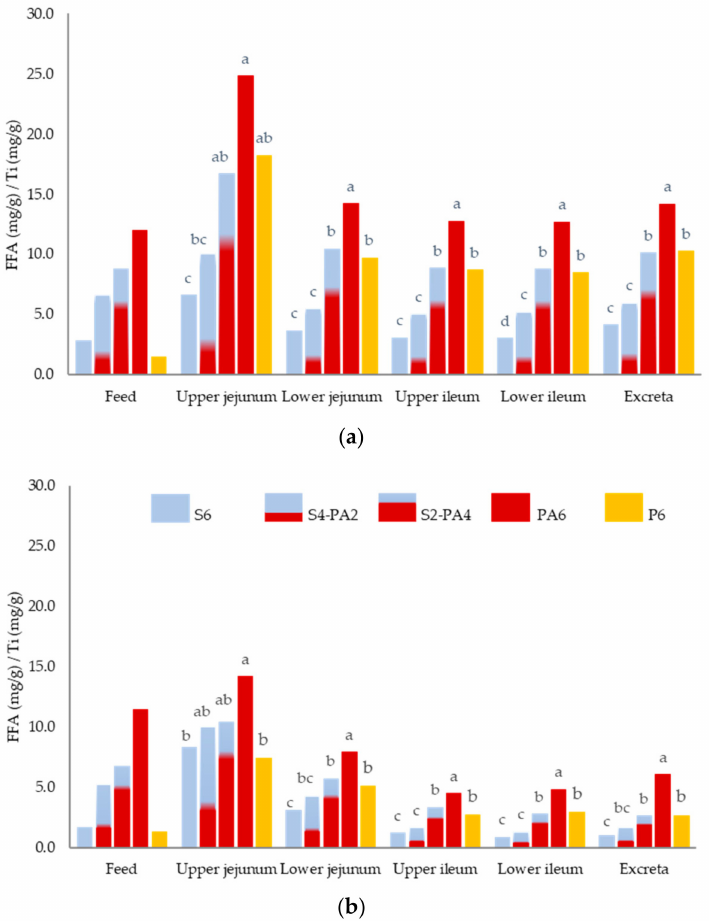
Figure 1. FFA content 1 in the feed, upper jejunum, lower jejunum, upper ileum, lower ileum, and excreta for the five different diets; with 6% of soybean oil (S6), blend with 4% soybean oil and 2% palm fatty acid distillate (S4-2PA), blend with 2% soybean oil and 4% palm fatty acid distillate (S2-2PA), with 6% of palm fatty acid distillate (PA6) and with 6% palm oil (P6) in ( a ) 11-d-old broiler chickens and ( b ) 35-d-old broiler chickens. 1 FFA concentration (mg/g)/Ti concentration (mg/g) in each intestinal segment and excreta. Values are pooled means of 6 replicates per each diet with 12 chickens/replicate at 11 d, and 2 chickens/replicate at 35 d. a–d: columns not sharing a common letter within each intestinal segment are significantly different ( p ≤